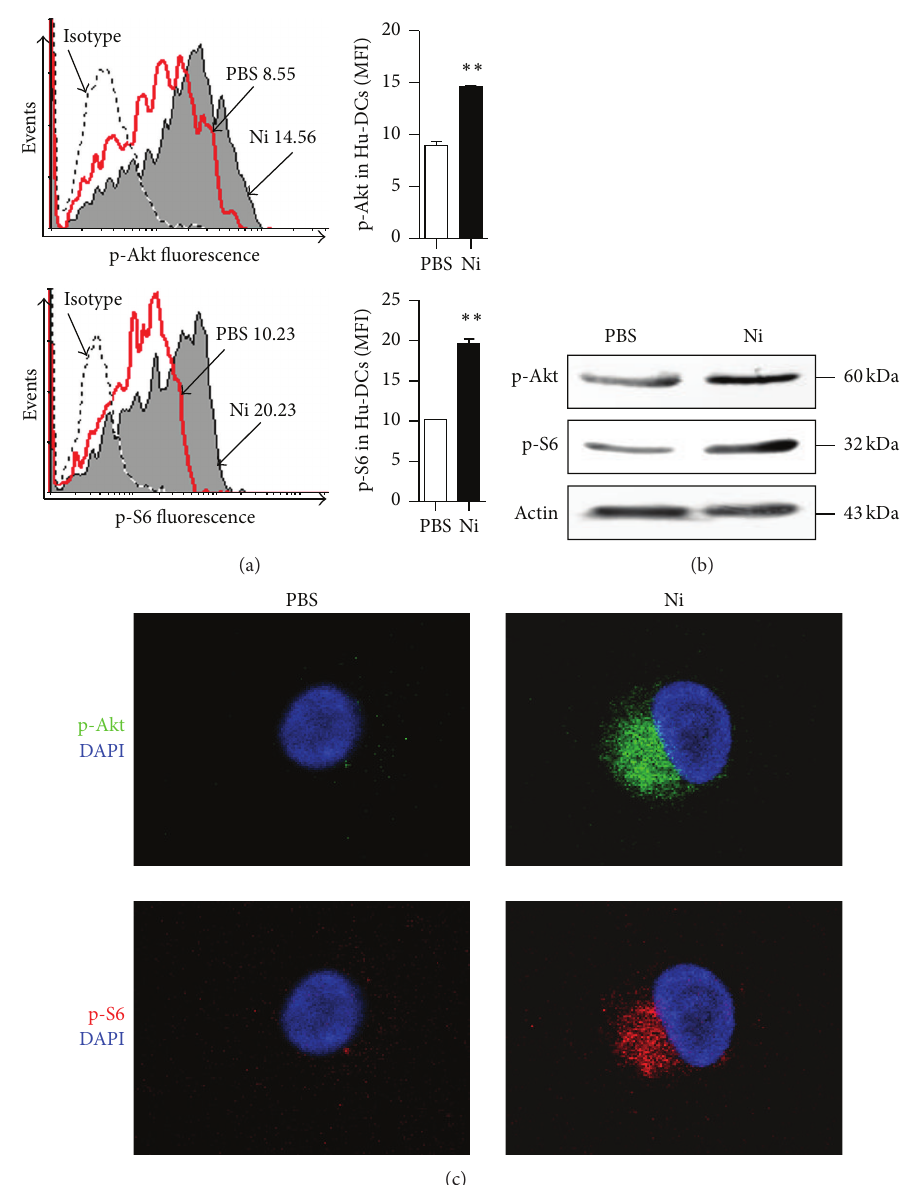
Figure 5: The treatment with nicotine induces Akt-S6 pathway activation in human semimature DCs. (a–c) Human PBMC-derived semimature DCs were stimulated with nicotine (10 −7 mol/L) for 15min and the phosphorylation of Akt and ribosomal protein S6 was determined by flow cytometry (a), Western blotting (b), and confocal microscope analyses (c), respectively. One representative from 3 independent experiments is shown. Numbers in histogram indicated mean fluorescence intensity (MFI) of test samples. Data were given as mean ± SEM, Student 𝑡 -test, ∗∗ 𝑃 < 0.01 . Ni: